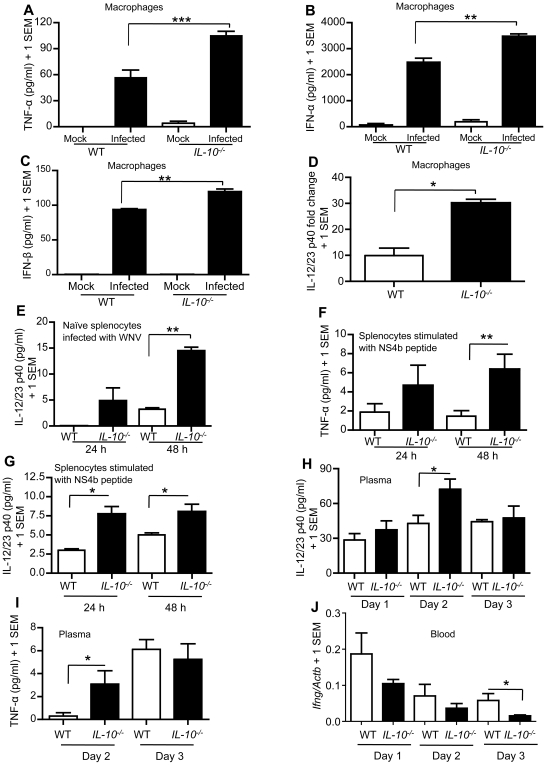
Immune cells and mice deficient in IL-10 produce more antiviral cytokines.Thioglycollate elicited peritoneal macrophages from IL-10−/− and wild-type (WT) mice were challenged with WNV (MOI = 1) or PBS (mock infection) for 24 hours. (A–C), TNF-α, IFN-α and IFN-β were measured in media by ELISA. (D), Total RNA from macrophages was analyzed for IL-12/23 p40 mRNA expression by Q-PCR. The data are normalized to mouse β-actin mRNA and are expressed as the relative fold increase over normalized RNA from mock controls. (E), Splenocytes isolated from naïve IL-10−/−and WT mice were infected with WNV (MOI = 0.5), and IL-12/23 p40 production was measured in media by ELISA. (F and G) Splenocytes isolated from WNV-infected IL-10−/− or WT mice on day 3 p.i. (LD50, i.p.) were stimulated by WNV NS4b peptide (1×106 cells, 1.0 µg/ml) for 24 or 48 hours. TNF-α (F) and IL-12/23 p40 (G) were measured in media by ELISA. (H and I) WT and IL-10−/− mice were i.p. challenged with WNV (LD50) and bled on day 1, day 2 and 3 p.i., and IL-12/23 p40 (H) and TNF-α (I) were measured in plasma by ELISA. (J), Expression of IFN-γ (Ifng) was measured in peripheral blood by Q-PCR. These data are representative of two independent experiments, with animal numbers ≥4 per group. *p<0.05, **p<0.01 and ***p<0.001.